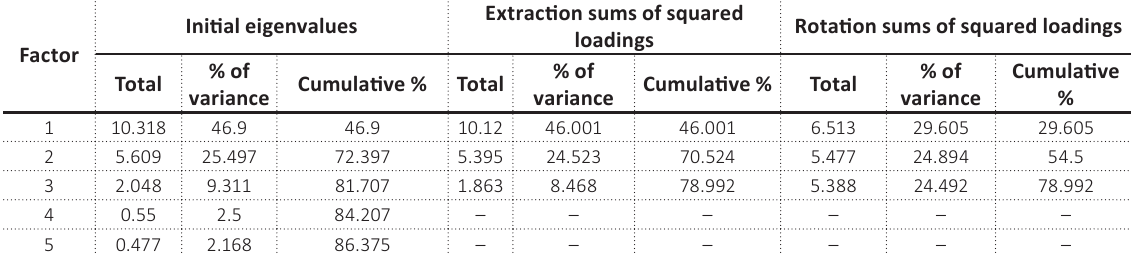
Table 1. Total variance